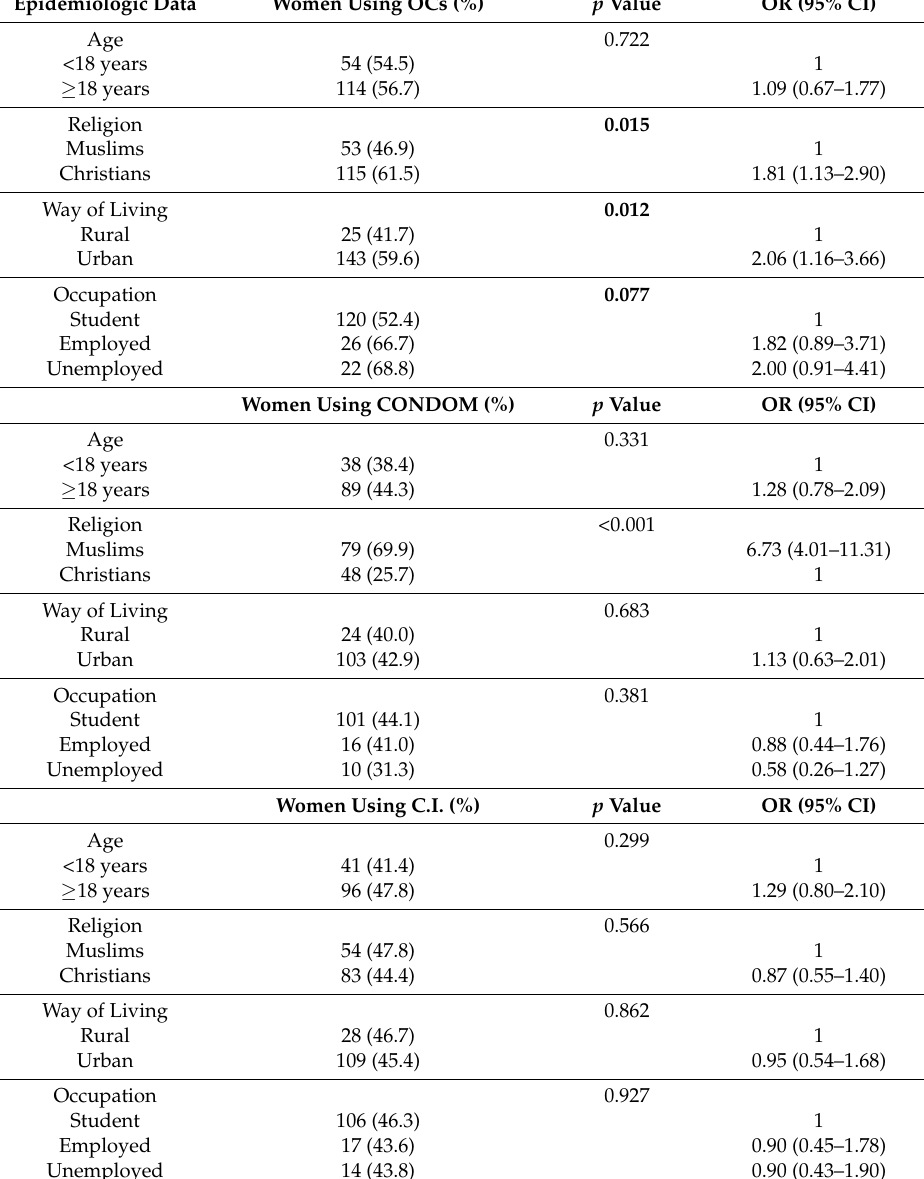
Table 4. Use of oral contraceptives, condom and interrupted coitus according to women’s